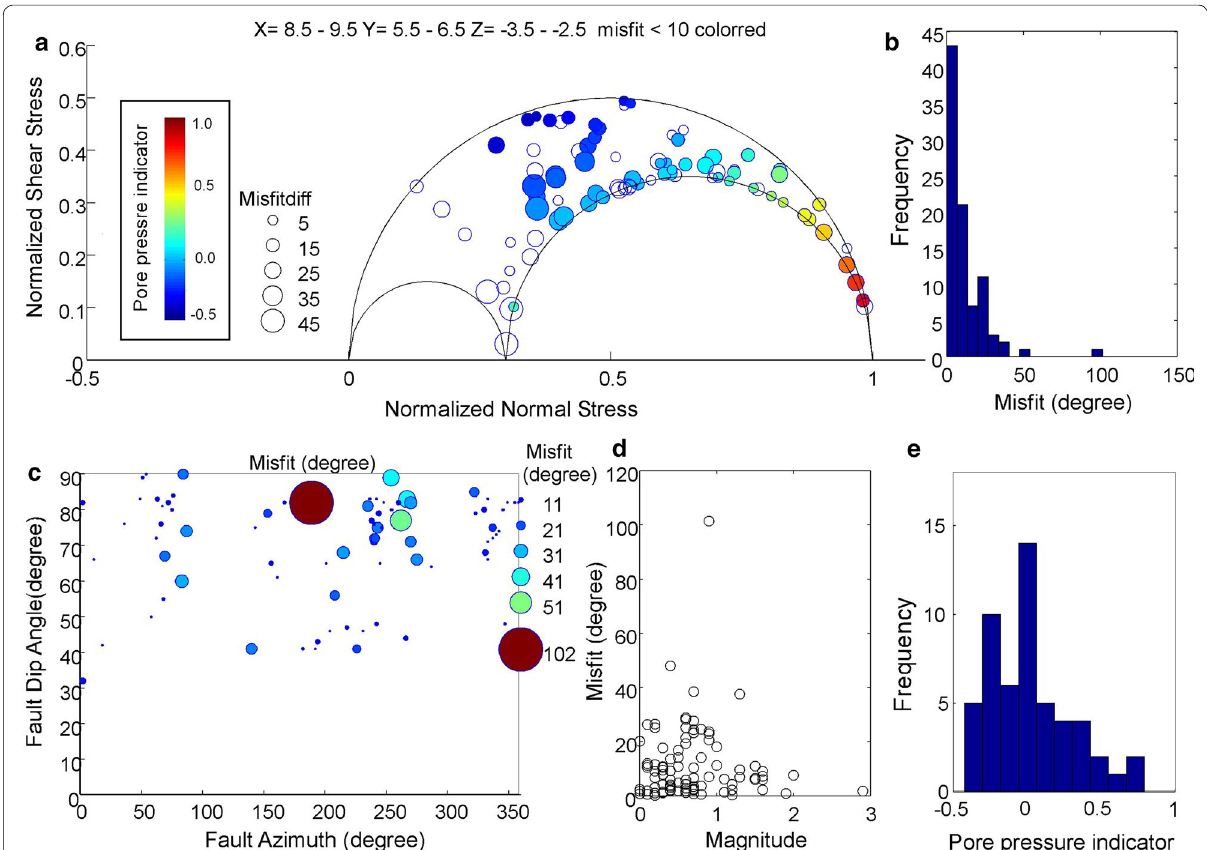
Fig. 10 a Plots of the normalized shear and normal stresses on faults on a three-dimensional Mohr diagram for a grid point ( x Pore pressure indicators P p are calculated as P p σ n τ / μ , where μ is assumed as 0.6. Sizes of circles represent the difference of misfits between the = − fault plane and auxiliary plane (misfitdiff); coloring indicates only data with misfits on the fault plane greater than the error of focal mechanisms, 10°. b Histogram of misfits. c Relationship between azimuths and dip angles of the fault planes. Misfits are also indicated by the sizes and colors of circles. d Relationship between magnitude and misfit. e Histogram of the pore pressure indicator, P p . The following figure is that for Fig.